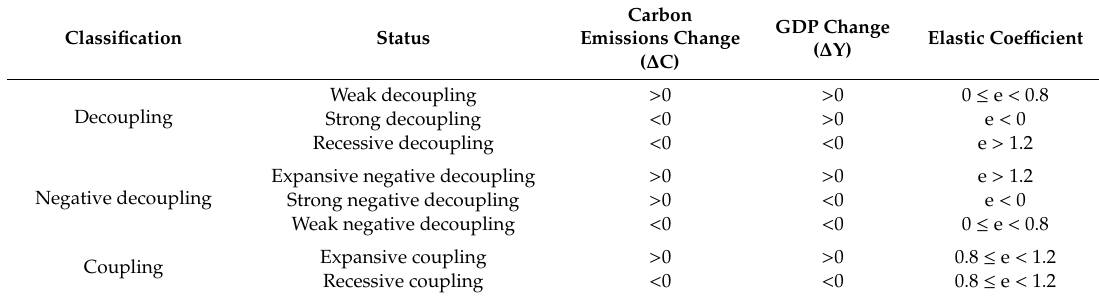
Table 1. Eight types of relationships for the Tapio decoupling model. GDP, gross domestic